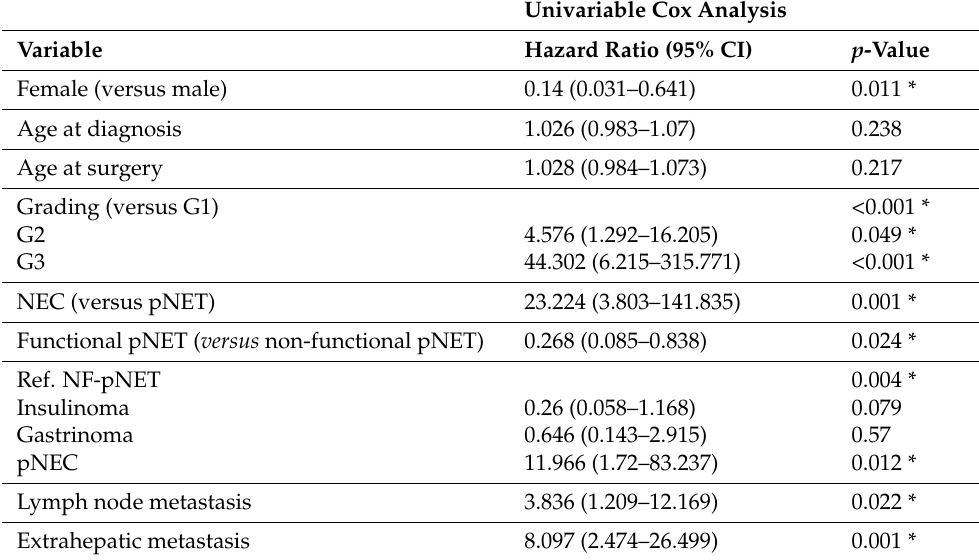
Table 2. Prognostic value of patient’s characteristics and autophagic transcript expression regarding overall survival in pNEN ( n = 54). * p < 0.05. Due to the high rate of loss to follow-up (18%), the risk of poor validity must be considered.